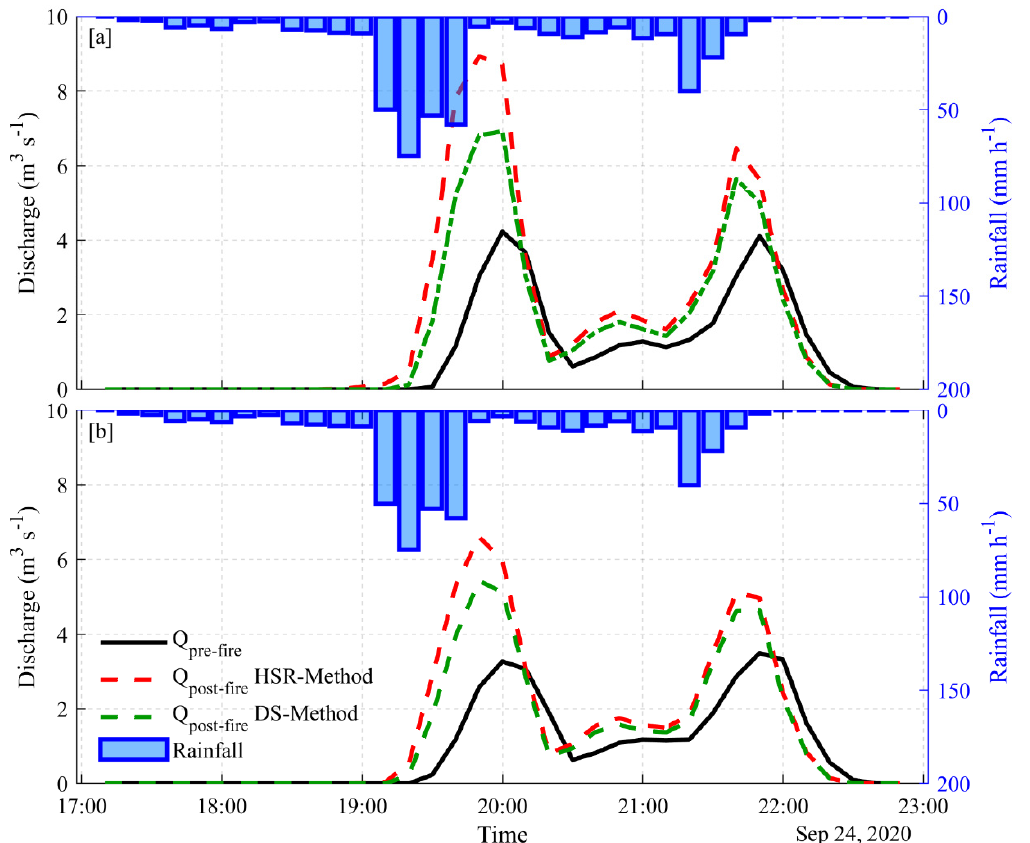
Figure 7. Tinella watershed runoff (Q) before and after the forest fire calculated with the HSR and DS methods. ( a ) Runoff formation from the WS10 sub-basin. ( b ) Runoff formation from the WS11 sub-basin. Rainfall intensity calculated as weighted average of the rainfall data recorded by the rain gauge network in the study area is also shown, indicating strikingly similar pluviographs.